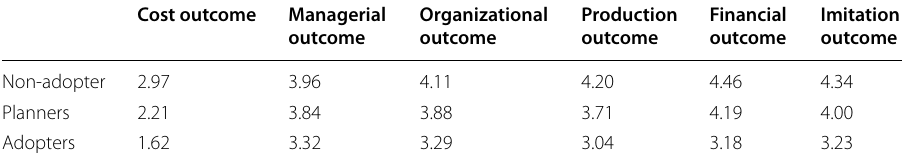
Table 9 Average intensity